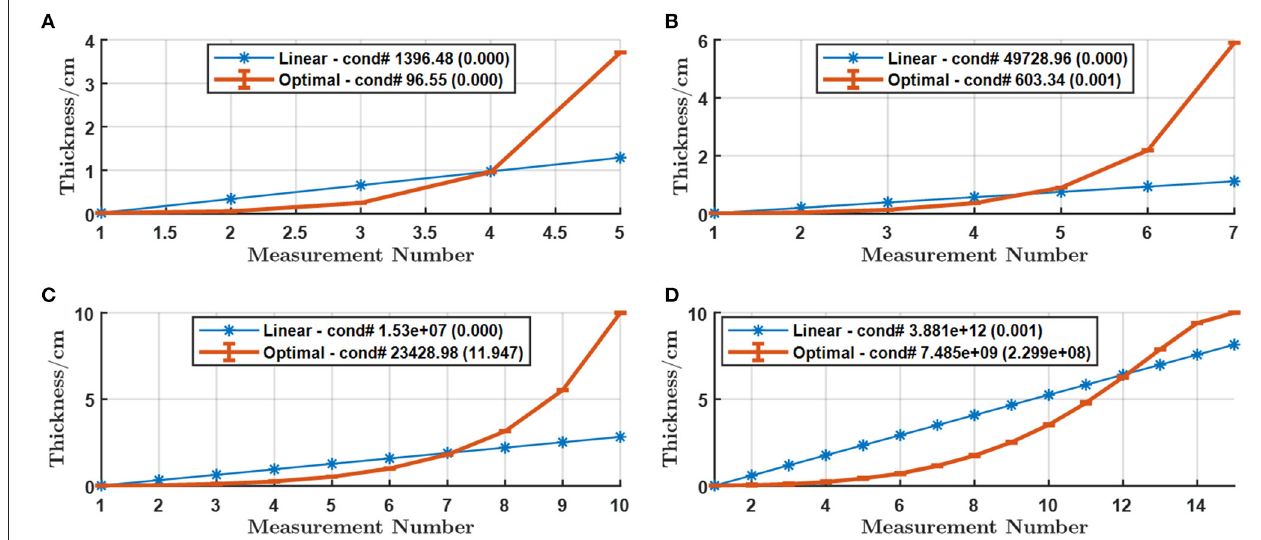
5 (B) M 7 (C) M 10 and (D) M 15 = = = =